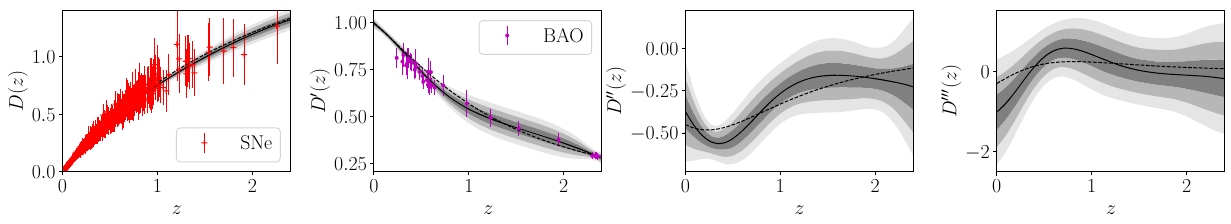
Fig. 6 Plots for the reconstructed dimensionless co-moving luminosity distance D ( z ) , it’s derivatives D (cid:3) ( z ) , D (cid:3)(cid:3) ( z ) and D (cid:3)(cid:3)(cid:3) ( z ) using combined Pantheon + BAO data. The black solid line is the best fit curve. The associated 1 σ , 2 σ and 3 σ confidence regions are shown in lighter shades. The specific points (in the top two figures) with error bars represent the observational data. The black dashed line is for the (cid:2) CDM model: (cid:12) m 0 = 0 . 3